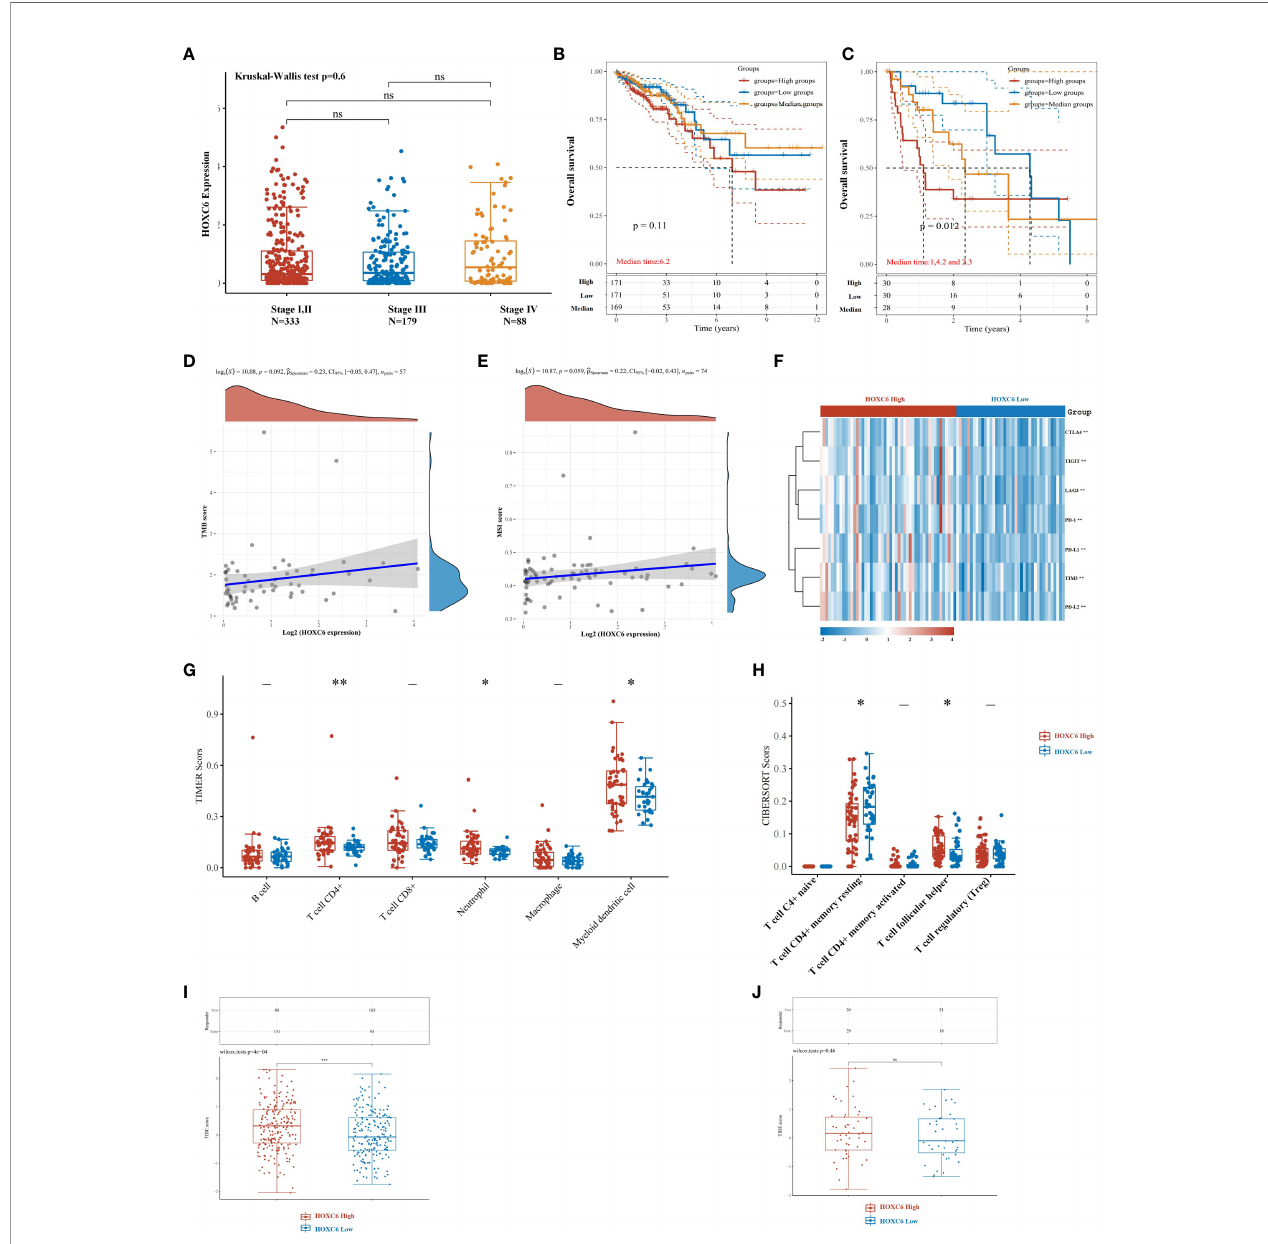
FIGURE 7 | High expression of HOXC6 signi fi cantly contributed to poor survival in stage IV with weakened immune microenvironment characteristics in CRC. (A) There was no signi fi cant difference in the expression of HOXC6 among stage I&II, stage III, and stage IV. (B) In stages I, II and III, high expression of HOXC6 had no signi fi cant contribution to poor survival ( P =0.11) (The whole cohort was divided into three groups equally according to the HOXC6 expression values. The median follow-up time for these three groups was 6.2 years). (C) In stage IV, high expression of HOXC6 contributed signi fi cantly to poor survival ( P =0.012) (The whole cohort was divided into three groups equally according to the HOXC6 expression values. The median follow-up times for the high, medium and low expression groups were 1, 4.2, and 2.3 years, respectively). (D) Expression of HOXC6 had no signi fi cant correlation with TMB score ( P =0.092). (E) Expression of HOXC6 had no signi fi cant correlation with MSI score ( P =0.059). (F) Immune checkpoints related gene expression heat map, where different colors represent the expression trend. (G) Expression of HOXC6 had a signi fi cantly positive correlation with the in fi ltration ratio of CD4+ T cell, neutrophils and myeloid dendritic cells. (H) Expression of HOXC6 had signi fi cantly positive correlation with the in fi ltration ratio of T cell follicular helper ( P <0.05). (I) The predicted immune response scores were signi fi cantly higher in the HOXC6-high expression group than in the HOXC6-low expression group which indicates worse predicted ICB ef fi cacy in the HOXC6-high expression group ( P <0.001). (J) The predicted immune response scores revealed no signi fi cance between the HOXC6-high expression group and HOXC6-low expression group. * P < 0.05, ** P < 0.01, ns, no signi fi